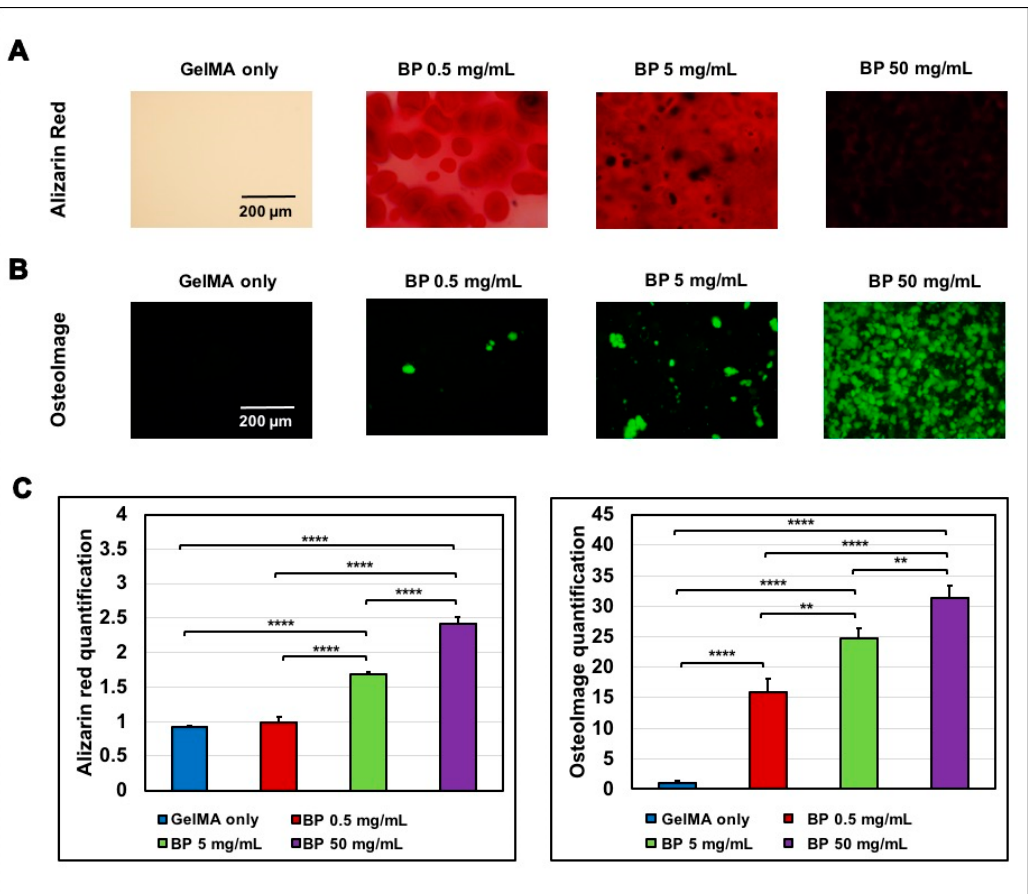
Figure 2. Evaluation of the calcium and hydroxyapatite components in the GelMA/BP composite hydrogels. The alizarin red images were taken by staining scaffolds without cells so that the alizarin red dye stains calcium content due to the presence of BP within the scaffolds. ( A ) Alizarin Red staining of calcium-rich portions (Scale bar: 200 µ m). ( B ) Osteoimage staining of hydroxyapatite portion in green (Scale bar: 200 µ m). ( C ) Quantification of the red color intensity in Alizarin Red staining (Error bars: ± SD, ** p < 0.01, **** p < 0.0001) and quantification of the green fluorescence in Osteoimage staining.